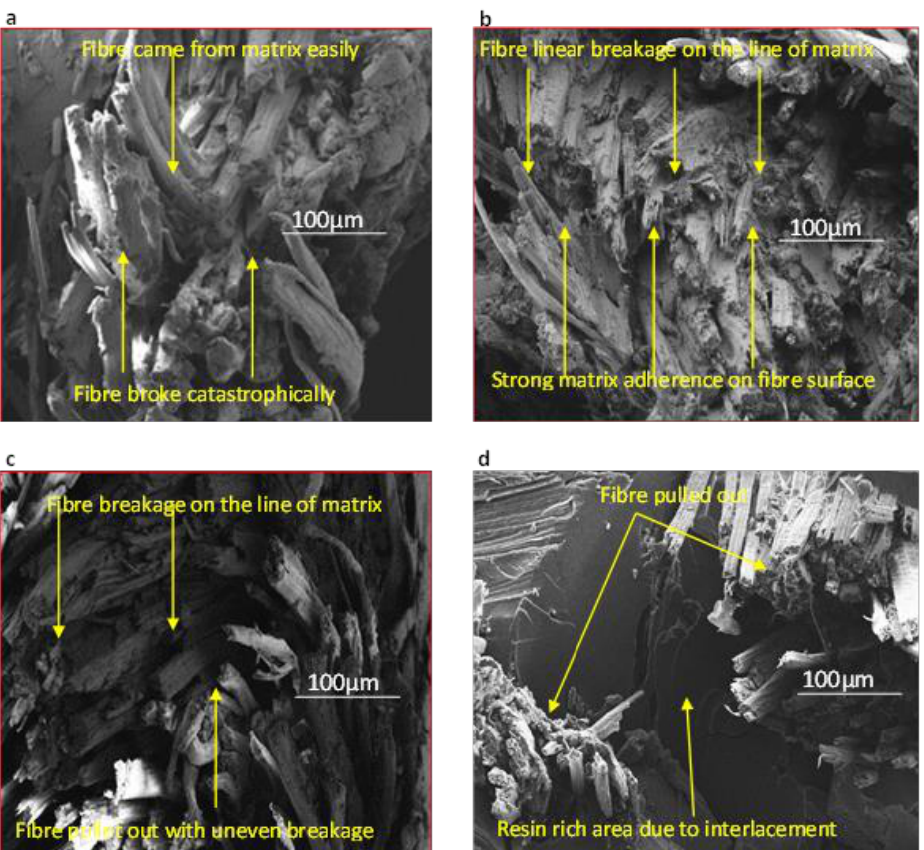
Figure 7. SEM images of fractured specimens after tensile test: ( a ) UD20 composite ( b ) UD25 composite ( c ) UD30 composite ( d ) W20 composite.